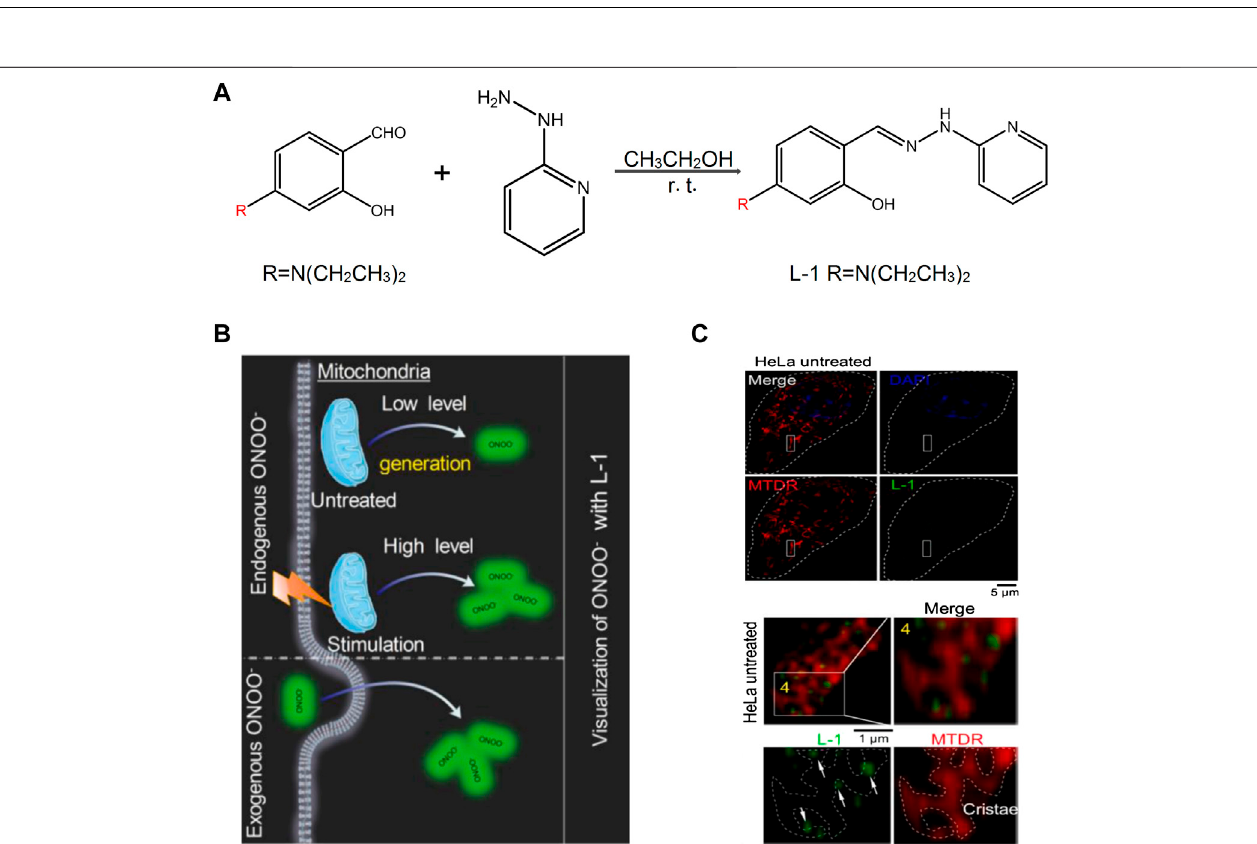
FIGURE3| Thedesignof L-1 anditsresponsewithONOO − (Liuetal.,2021). (A) Syntheticrouteofprobe L-1 . (B) ProposedONOO − visualizationmechanismsfor probe L-1 in living cells. (C) Super-resolution visualization of ONOO − using L-1 in living cells.